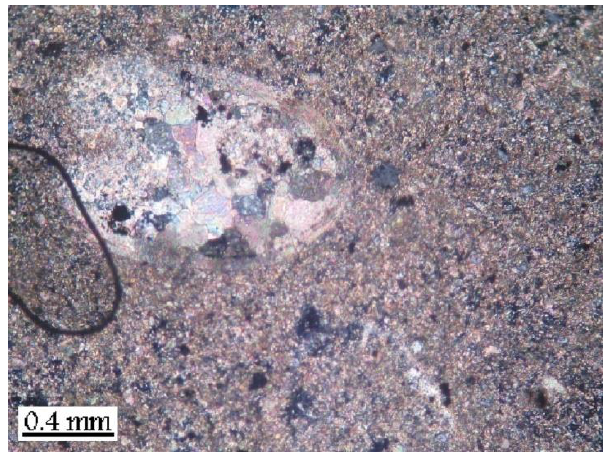
Figure 11. Anhydrification of fossil